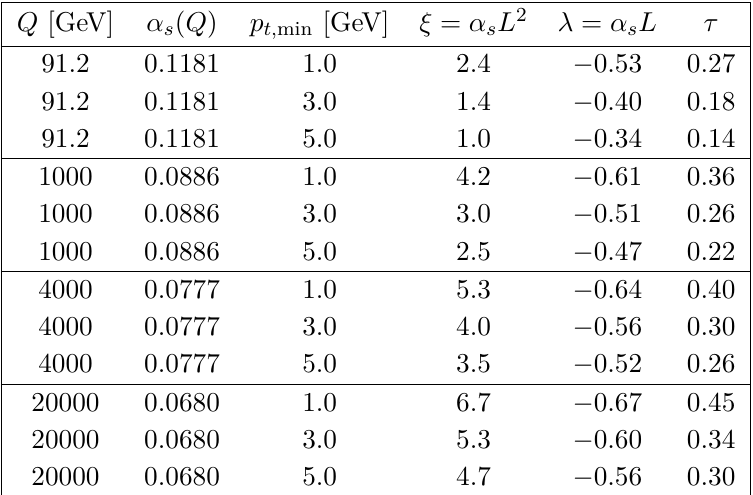
Table 1. Values of ξ = α s L 2 , λ = α s L and τ (defined in eq. (7.10)) for various upper ( Q ) and lower ( p ) momentum scales. The coupling itself is in a 5-loop variable flavour number scheme [45–48], t, min while τ is evaluated for 1-loop evolution with n